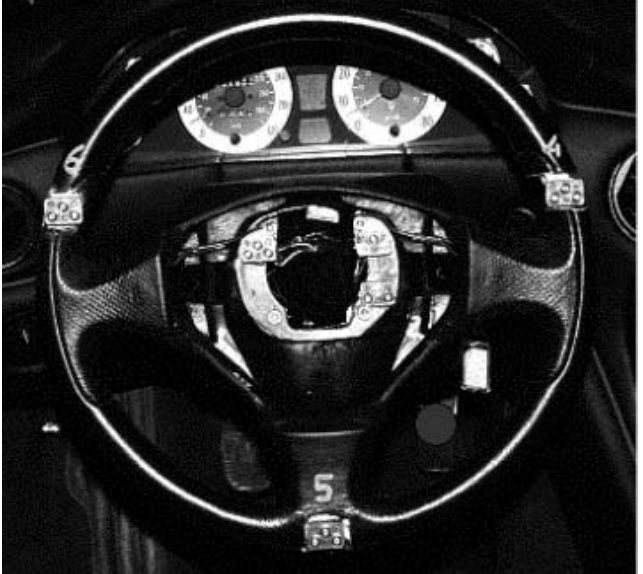
Fig. 6. Instrumented steering wheel.